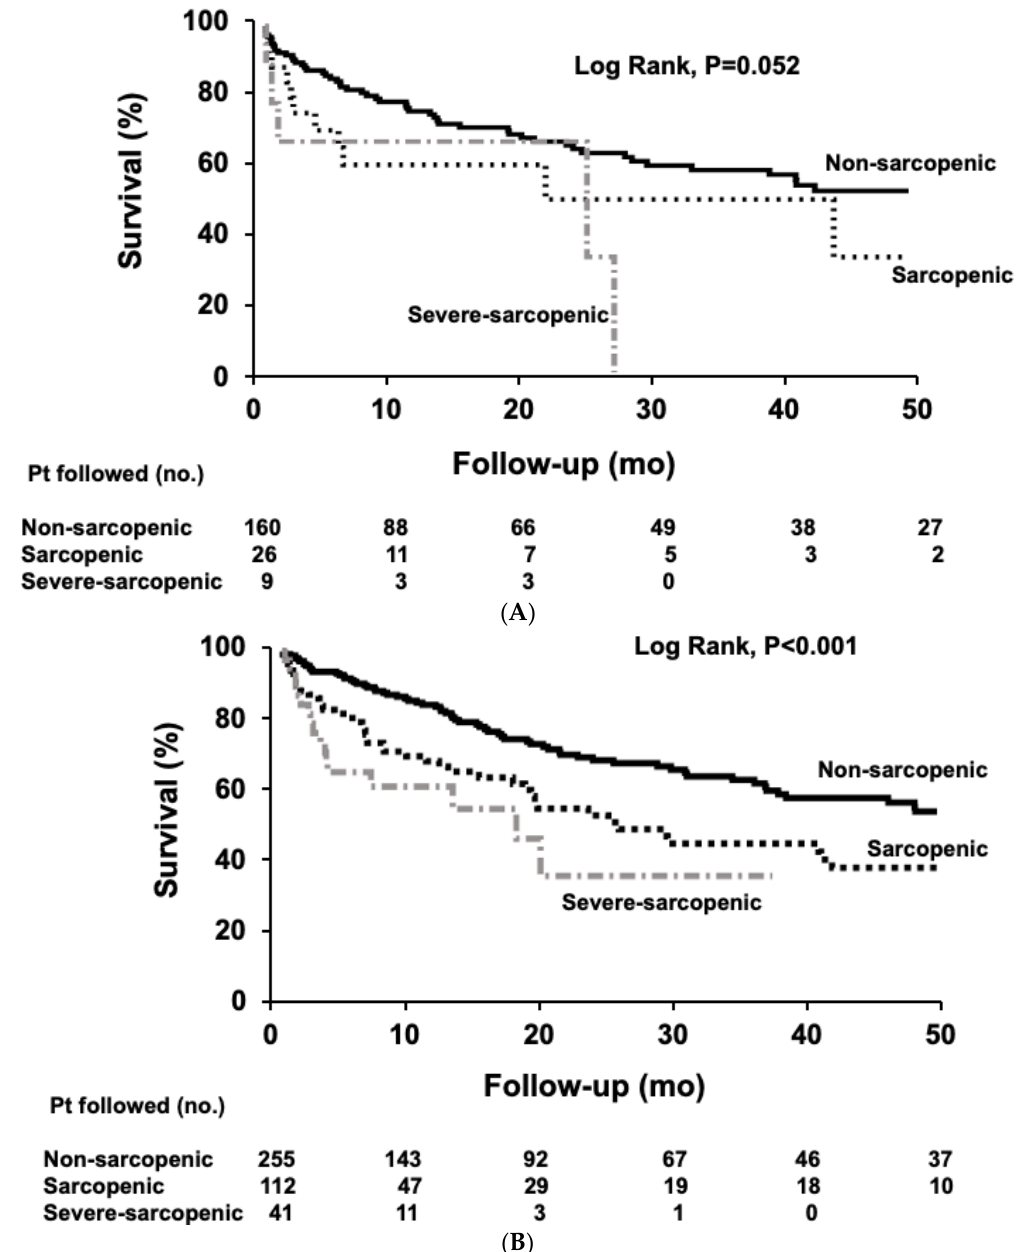
Figure 5. Survival curves in patients with cirrhosis according to the sarcopenia severity. ( A ) Females ( B ) Males. Survival over time was assessed using Kaplan-Meier curves and the curves were compared using the log-rank test. Significantly longer median survival was observed in non-sarcopenic patients compared to the sarcopenic and severe-sarcopenic patients, in males. (Log-rank < 0.001). Pt, patient; mo, months; no, number